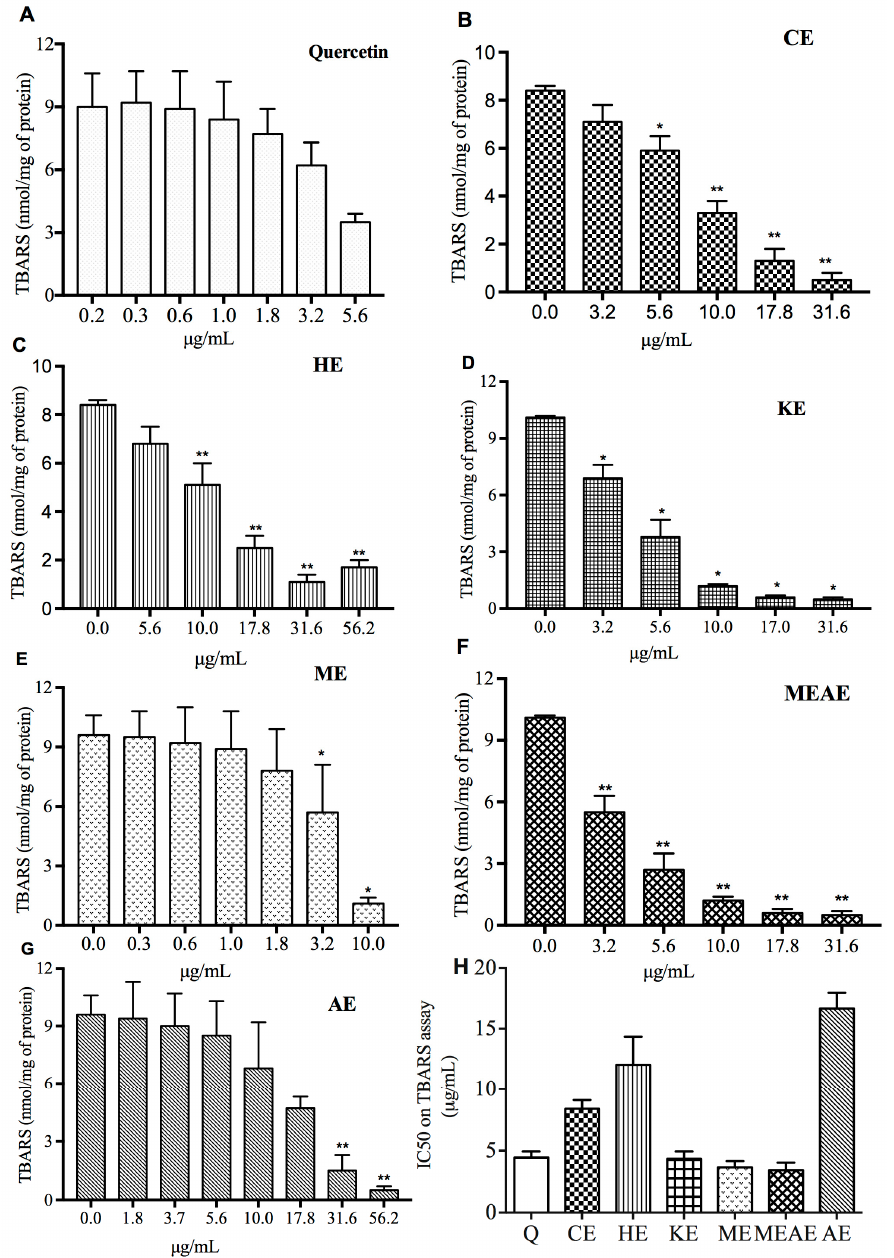
Figure 4. Inhibition of lipid peroxidation ( A – G ) and inhibitory concentration 50% (IC 50 ) values ( H ) of the extracts from AF pods and standard quercetin, quantified by lipid peroxidation (TBARS) production. CE = chloroformic extract; HE = hexanic extract; KE = ketonic extract; ME = methanolic extract; MEAE = methanolic:aqueous extract and AE = aqueous extract. Q = quercetin. The data are the mean with the standard error of three independent repetitions. * p < 0.05 and ** p < 0.01 vs. control group.